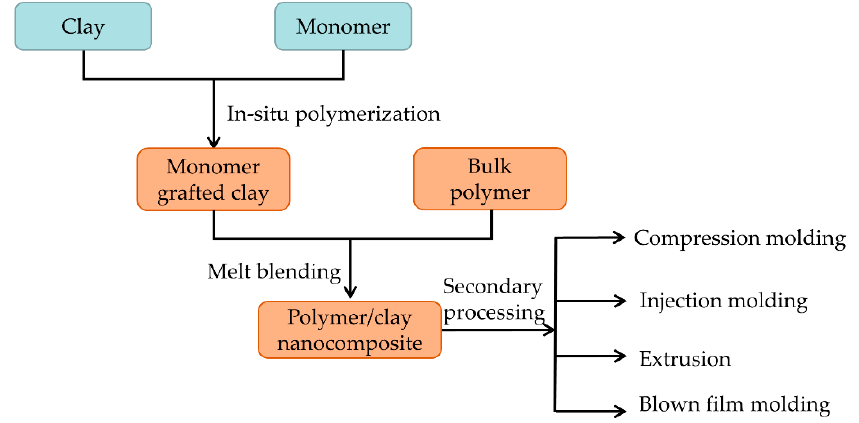
Figure 4. In ‐ situ polymerization method scheme. Figure 4. In-situ polymerization method